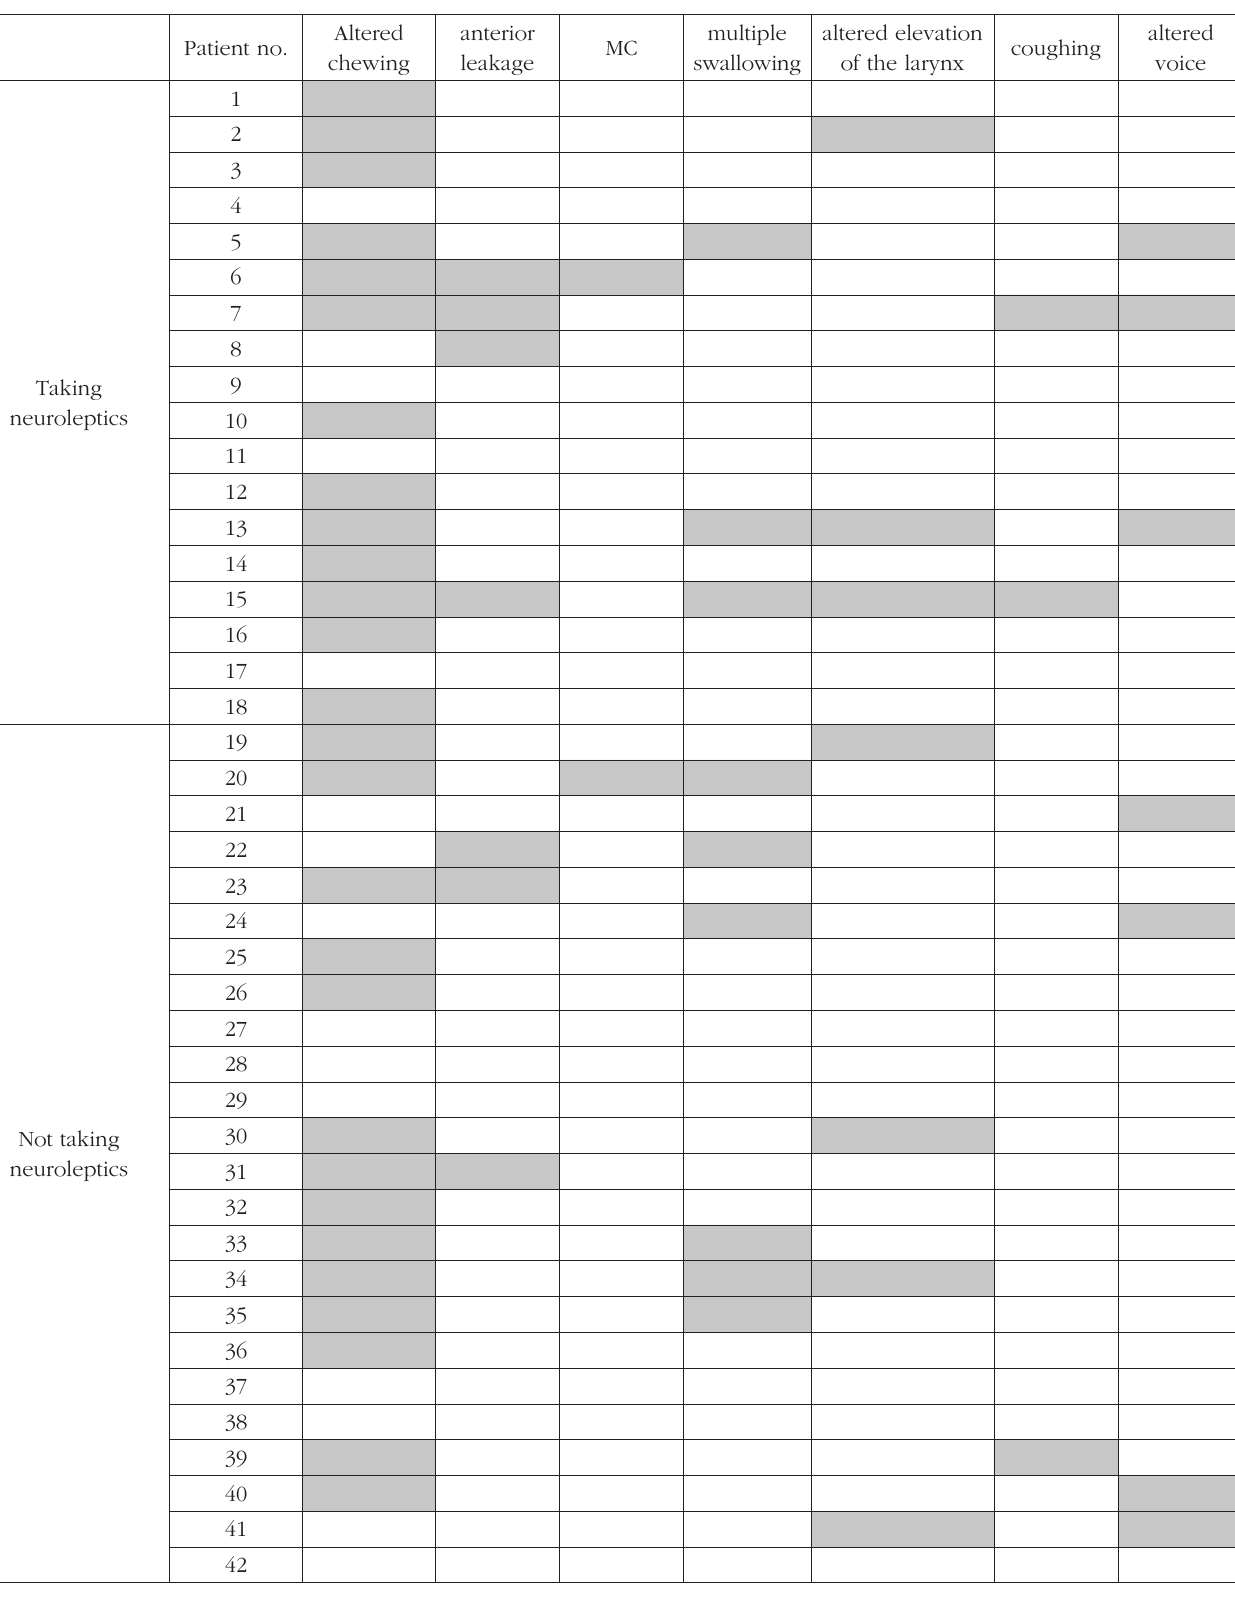
Table 3. Clinical signs in both groups.